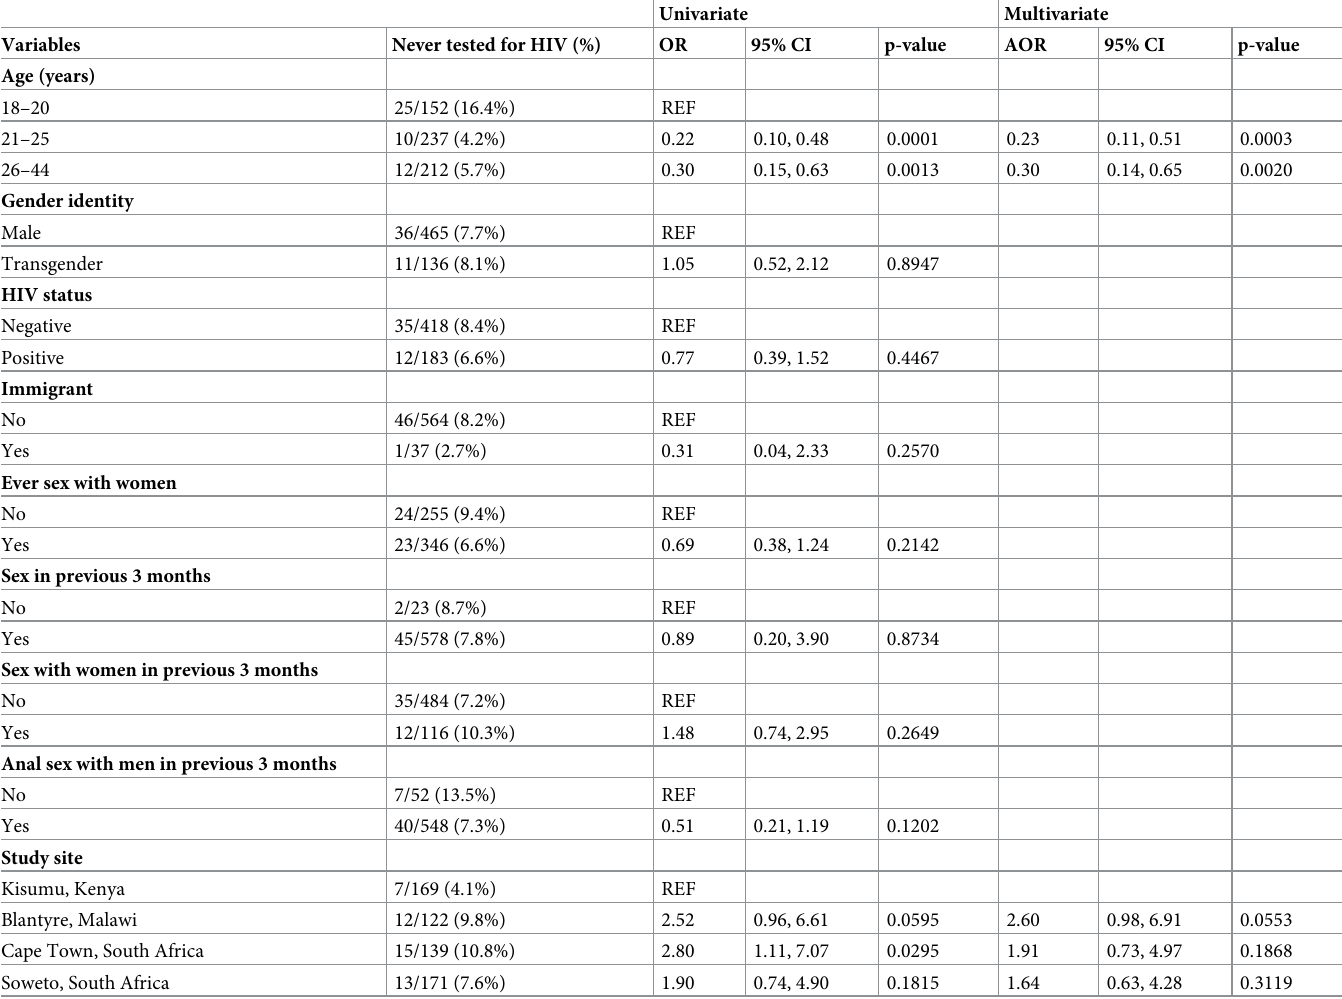
Table 2. Characteristics of never having tested for HIV among MSM and TW screened for participation in HPTN 075 (N = 601) a